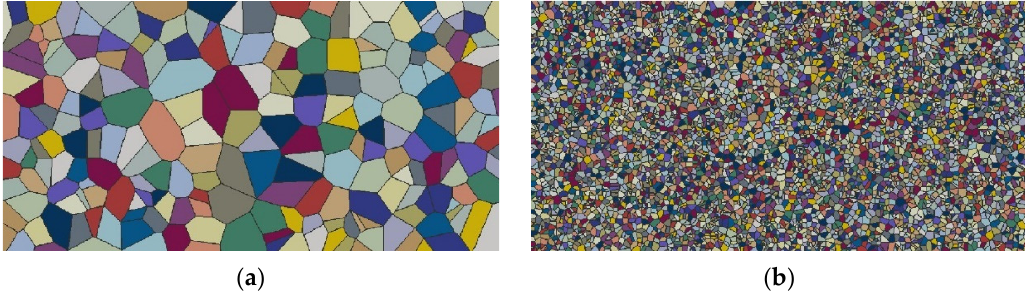
Figure 4. Macroscopic size and properties assignment of polycrystal model.